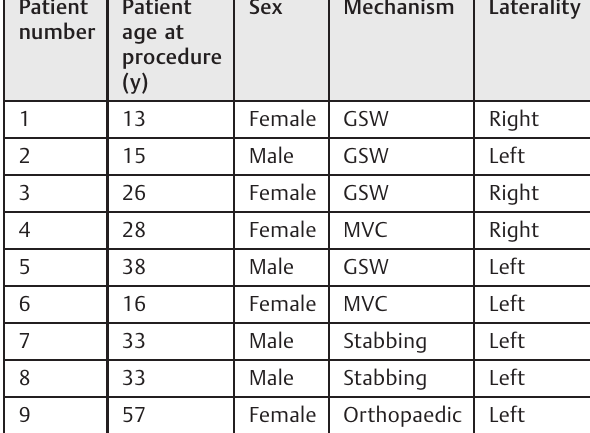
Abbreviations: GSW, gunshot wound; MVC, motor vehicle